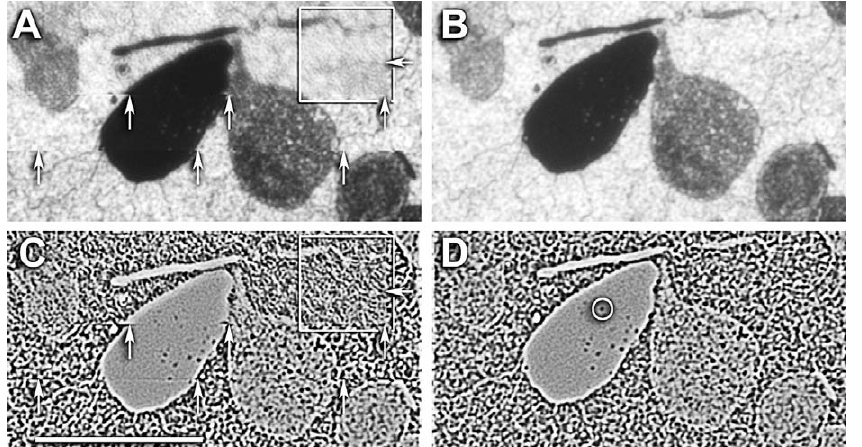
Figure 7. Auto-Registration of ssLM Image Tiles with ir-translate and ir-grid-refine A thin 200-nm section was probed with anti-AGB IgGs after excitation of the rabbit retinal GC layer [60], visualized by silver-intensified immunogold detection [54], captured on a SyncroscanRT montaging system (182 nm/pixel), and aligned with Syncroscan software (A and C) and ir-translate/ir-grid- refine (B and D) . At low magnification, both images appear perfect, but at near pixel level, many small defects emerge in the Syncroscan-aligned mosaic (arrows in [A and C]) that include 200–2,000-nm image shifts and image blurring (box). By using the raw image tiles and their metadata, ir-translate and ir-grid-refine create defect-free mosaics. While the image shifts shown in (A) are irrelevant (indeed invisible) for image display, they are highly corrupting in mathematically sensitive procedures such as clustering and multimodal alignments with ssTEM datasets. (A and B) are bright-field images and (C and D) are contrast-stretched Laplacian filtered images that enhance discontinuities and clearly show alignment defects. The circle in image (D) represents a lysosome of approximately 200 nm diameter. Its contrast is better preserved in the ir-translate and ir-grid-refine mosaic . Scale ¼ 20 l